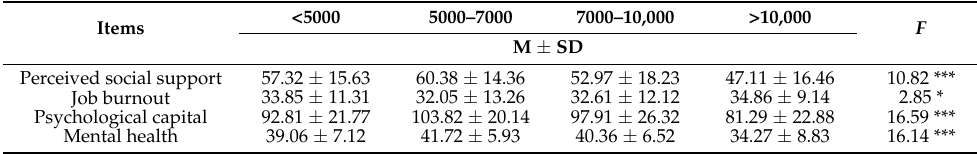
Table 15. Variance analysis on various variables with different monthly income.